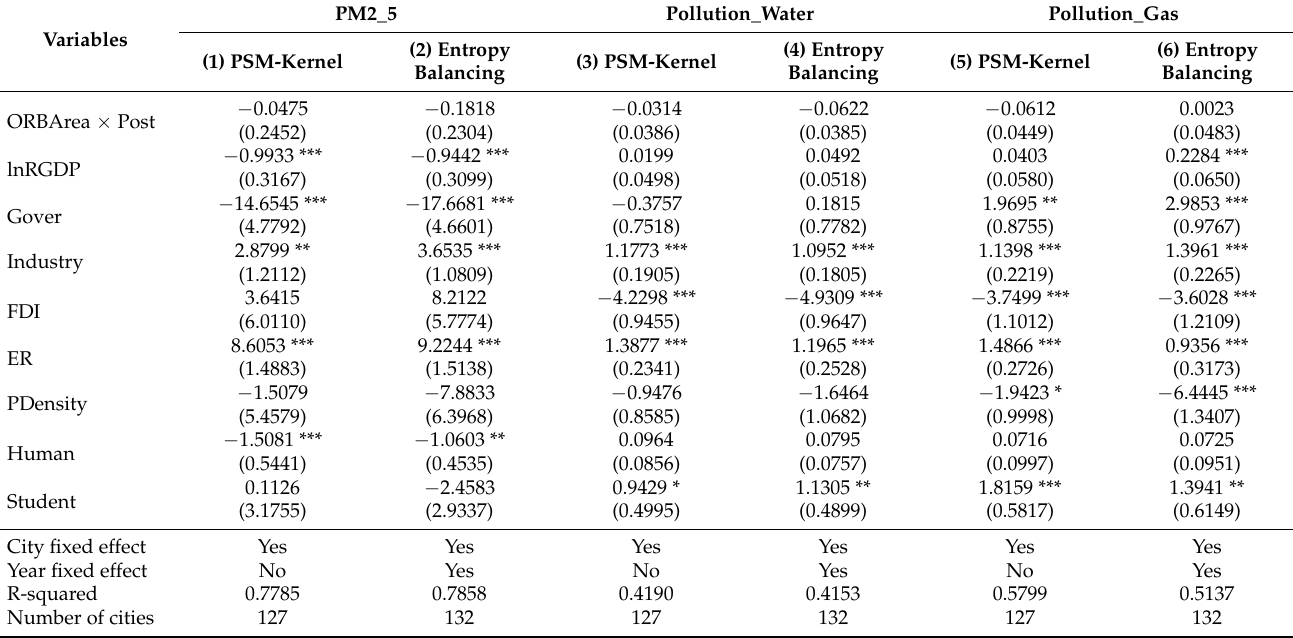
Table 10. Empirical results of the pollution effect